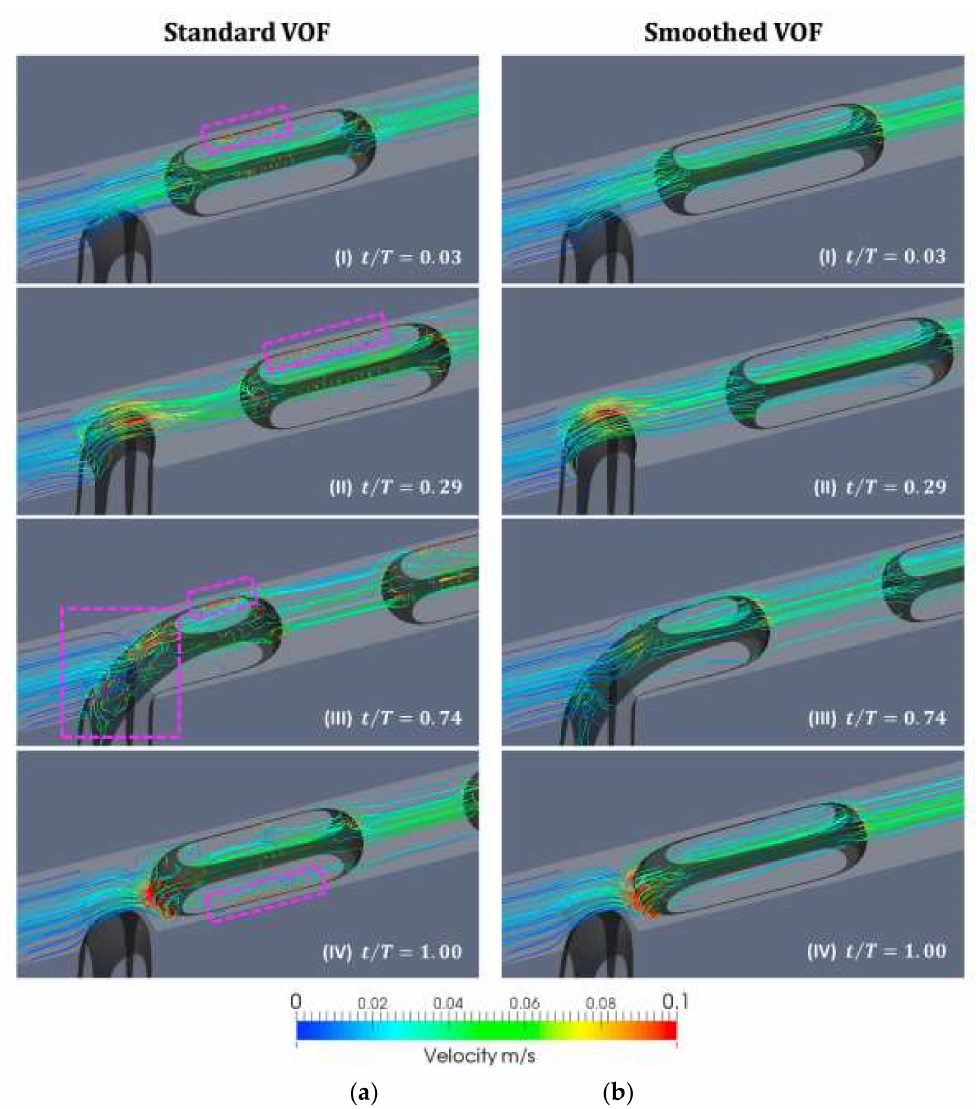
Figure 6. The flow fields near the interface during the droplet formation process, by ( a ) the Volume of fluid method (VOF) method and ( b ) the improved VOF method. Spurious velocities appeared near the interface in the VOF model. Reprinted from